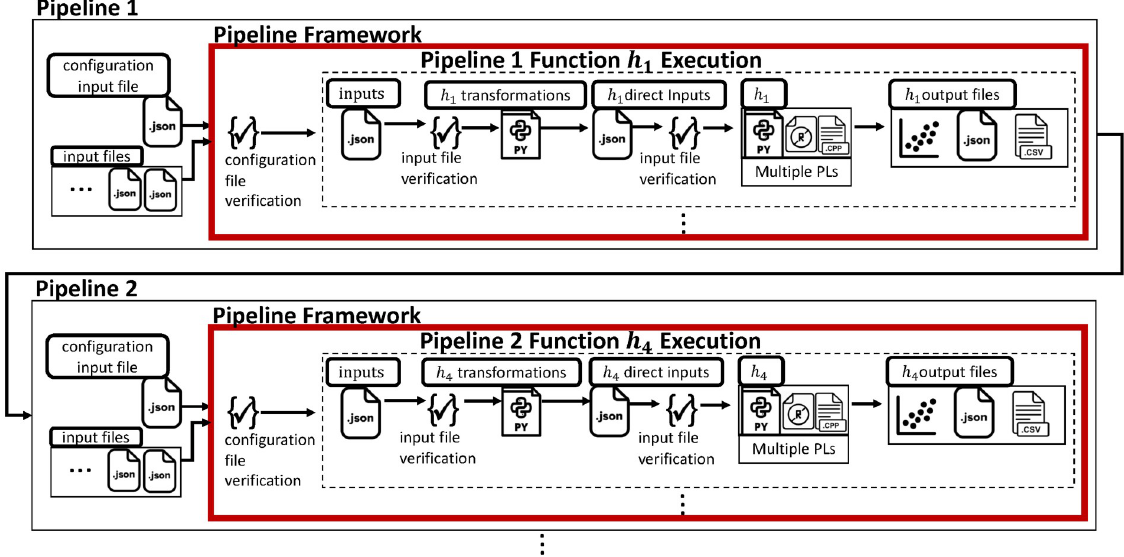
Fig 11. Two pipelines are shown to illustrate similarities and differences between them. To run a pipeline (called a job), a pipeline-specific configuration input file is verified and is read by the pipeline framework. The file specifies h -functions and their order of execution, as well as required input files to the pipeline. Here we show how function h 1 is executed in a pipeline 1 and how h 4 is executed in pipeline 2. The pipeline framework invokes the corresponding functions. If specified in the configuration file, the pipeline framework invokes a transformation function that transforms the contents of one or more files into an input file of correct format for the h -function. There may be one transformation function for each direct input to an h -function. At appropriate points in a pipeline, data files are verified against their corresponding JSON schema (input file verification). The h -function is executed and output files are generated (these digital object outputs may be, e.g., plot files, ASCII data files, and binary data files). There may be additional h -functions within pipeline 1, indicated by the ellipsis below pipeline 1 function h 1 execution. In this example, outputs from the generic pipeline 1 are inputs for the generic pipeline 2. Function h 4 in pipeline 2 is executed in a similar fashion to function h 1 in pipeline 1. See the text for descriptions of these various components. Note: the pipeline framework (in brown) is the same code for all pipelines. See Table 5 for implementation details of the elements in this figure.